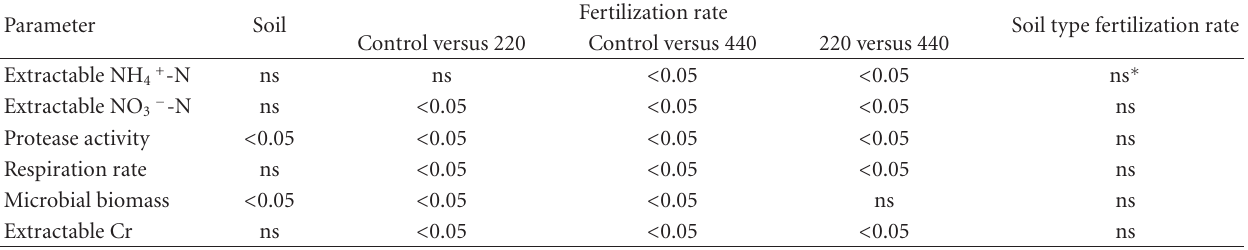
Table 3: Results of the F -test from an overall ANOVA for extractable NH 4 + -N, extractable NO 3 − -N, protease activity, respiration rate, microbial biomass, and extractable Cr.